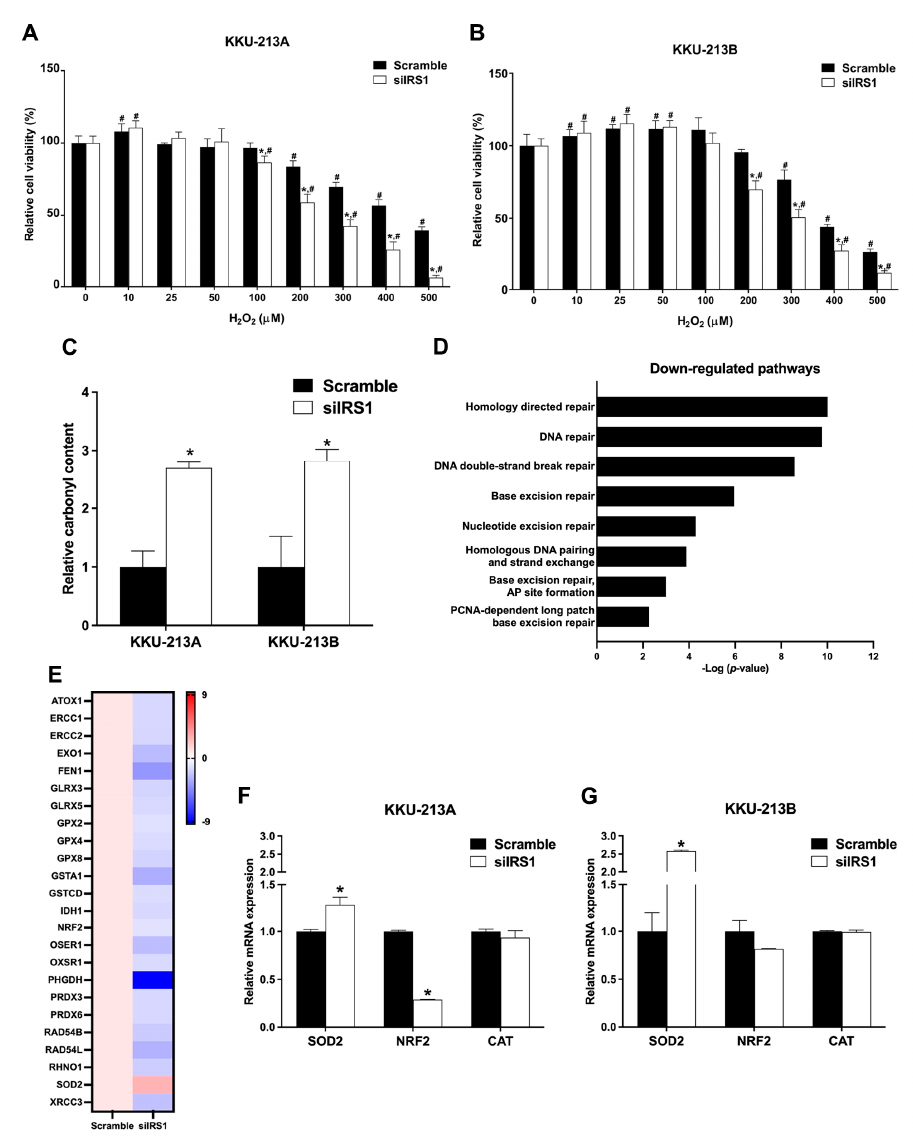
Figure 9 . Effect of IRS1 knockdown on oxidative stress-resistant properties of CCA cell lines. ( A , B ) Relative cell viability percentage (detected by MTT assay) of KKU-213A and KKU-213B after IRS1 knockdown following 48 h of H 2 O 2 treatment. ( C ) Bar graph representing relative protein carbonyl content in CCA cell lines after IRS1 knockdown. ( D ) Down-regulated pathways in IRS1 knockdown KKU-213B cells analyzed by Reactome pathway analysis. ( E ) Heatmap representing fold changes of expression of antioxidant genes in IRS1 knockdown KKU-213B cells investigated by RNA sequenc- ing. ( F , G ) The mRNA levels of SOD2, NRF2, and CAT in CCA cell lines after siIRS1 transfection. * p -value < 0.05 compared to scramble and # p -value < 0.05 compared to 0 μ M of H 2 O 2 . 3. Discussion IRS1 is a cytoplasmic adaptor protein that transmits insulin and insulin-like growth factor receptor signals in the insulin signaling pathway, which controls various cellular processes [10]. IRS1 has been discovered in the nucleus of cancer cells, where it plays syn- ergistic roles with IRS1 in the cytoplasm to stimulate cell cycle progression, DNA repair, cell proliferation, and estrogen responsiveness [16–18]. IRS1 has been linked to the devel- opment and progression of various cancers, including breast, prostate, and pancreatic can- cers [11–14]. IRS1 expression is elevated in breast invasive ductal carcinoma and associ- ated with p-Akt expression and a poor prognosis for the patients [11]. Meng et al. demon- strated that the inhibition of IRS1 expression reduces proliferation of prostate cancer cells,